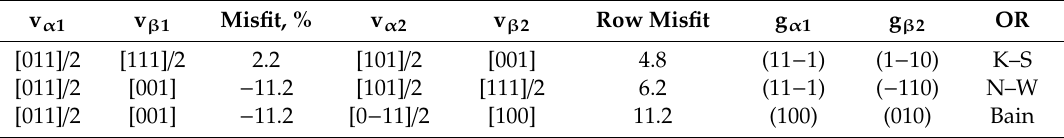
Table 2. Predicted orientation relationships (ORs) and interfacial orientations (IOs) with the near atomic row matching method in the fcc / bcc system.